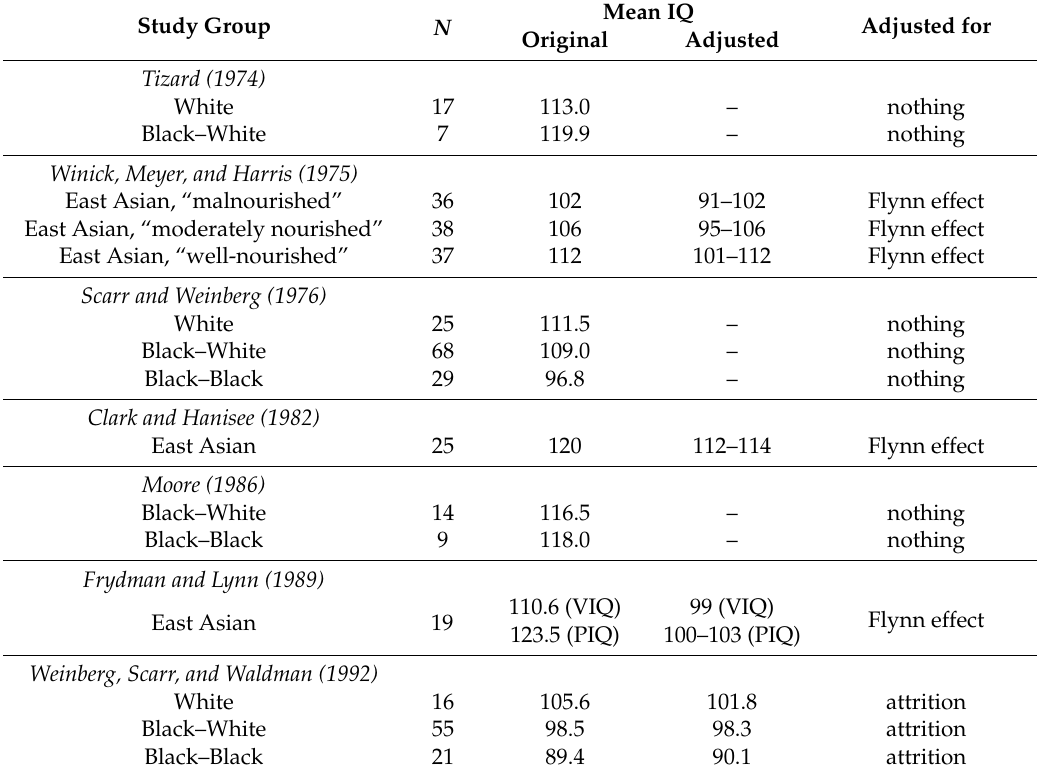
Table 2. Studies of IQs of transracial adoptees adopted by Whites: partially adjusted results. Study Group